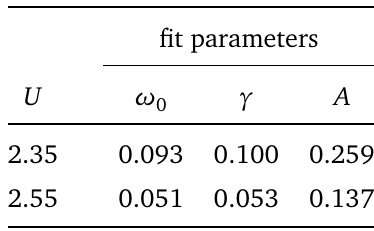
( i ω ) for selected U -values at β = n HO